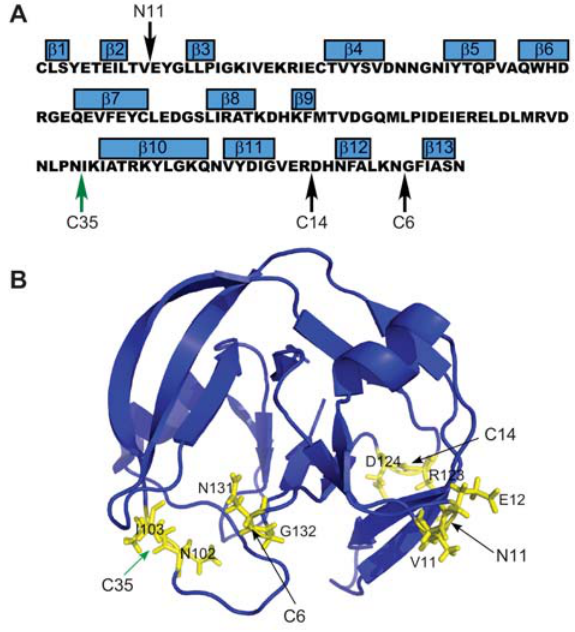
Figure 3 Split sites in the Npu DnaE intein. (A) Amino acid sequence of a cis -splicing version of Npu DnaE with b -strands from the nuclear magnetic resonance (NMR) struc- ture and split sites indicated above the sequence. Split site ‘C35’ (highlighted in green) refers to the natural split intein. (B) NMR structure of Npu DnaE w PDB code: 2KEQ; (32) x with the split site positions indicated with arrows. All functional split sites are located in loops. The native and artificial split sites are indicated with green and black arrows,